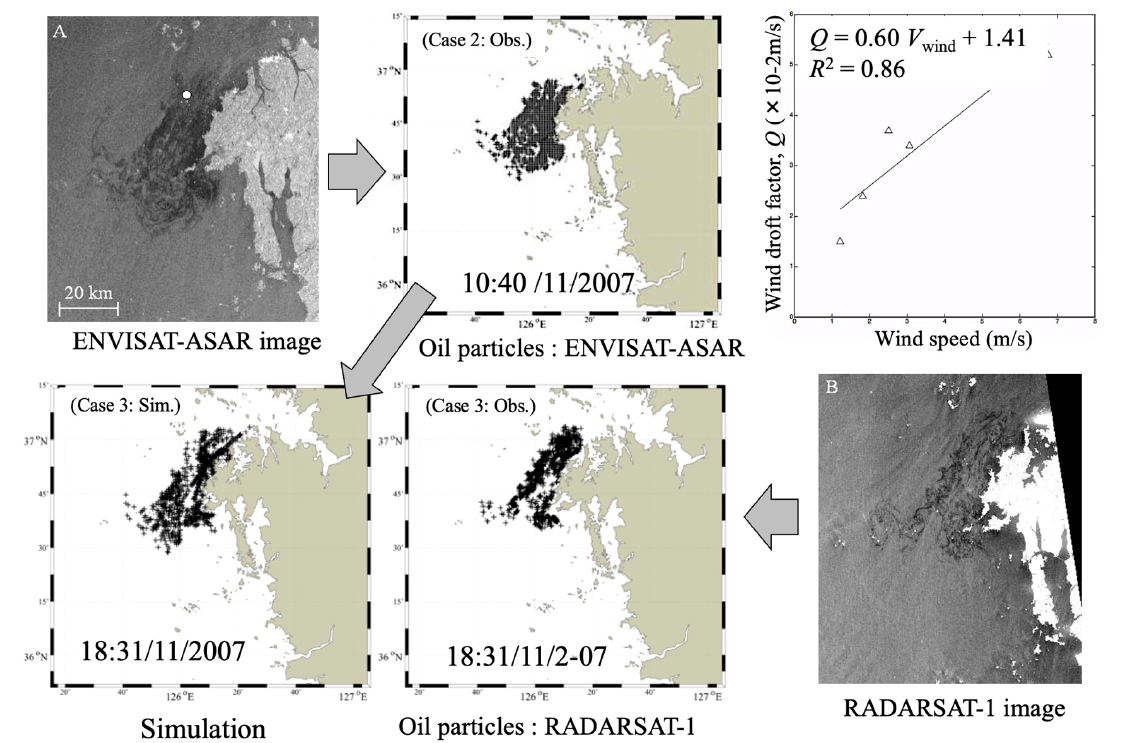
Figure 20. ( A,B ) An example of the prediction of oil slick movement for the Hebei Spirit tanker oil spill off the west coast of Korea shown in Figure 15. Oil particles are extracted from the ENVISAT-ASAR image and simulated and compared with the oil particles in the RADARSAT–1 SAR image. The top– right image shows the optimum wind drift factor in terms of wind speed. [137].